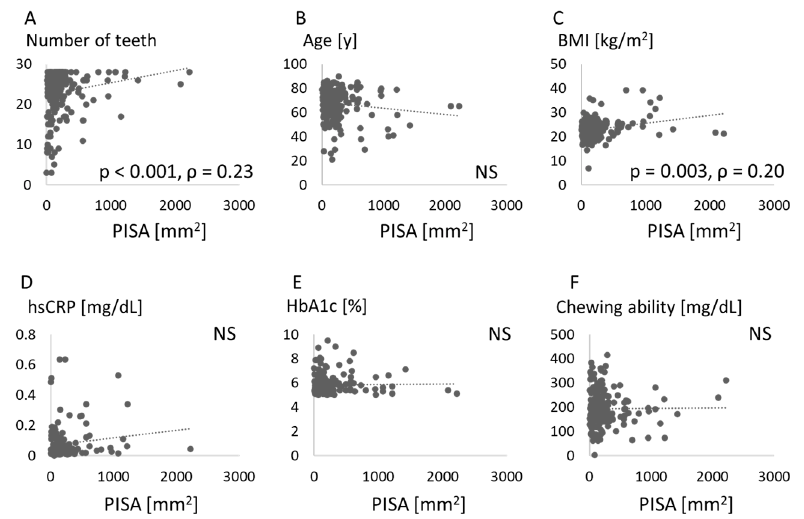
Figure 1. Association between each score and periodontal inflamed surface area. Number of teeth ( A ), age ( B ), body mass index (BMI) ( C ), high-sensitivity C-reactive protein (hsCRP) ( D ), hemoglobin (Hb)A1c ( E ), and chewing ability ( F ) are compared with periodontal inflamed surface area (PISA). NS: not significant.